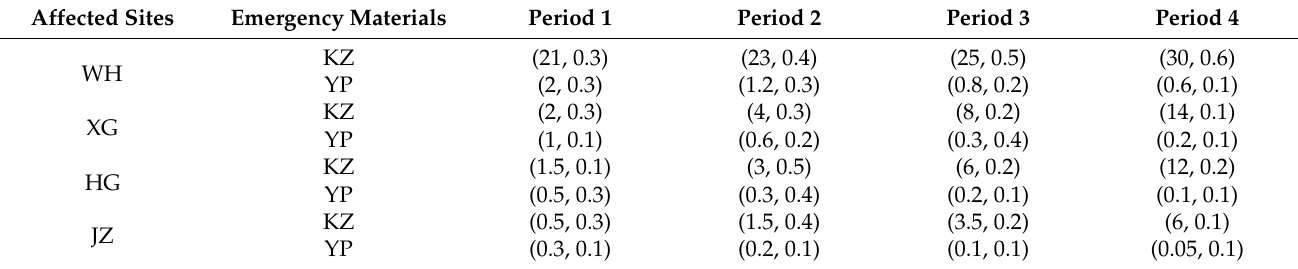
Table 2. Demand for emergency materials at affected sites at the beginning of each time period.